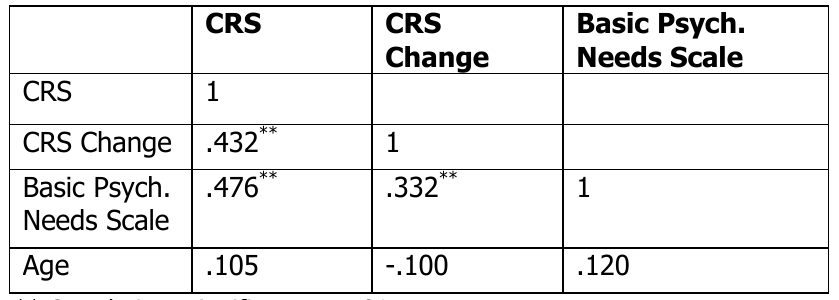
Correlations for Cross-structure analysis